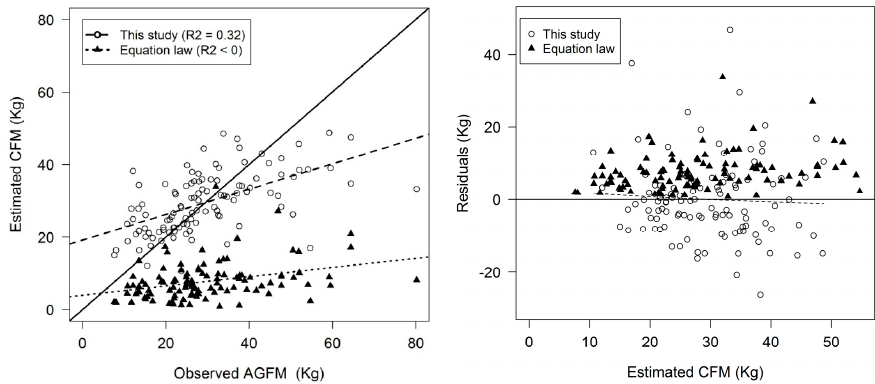
Figure 7. ( Left ) Comparison between allometric equation of this study and law-based equation for estimating rosewood crown fresh mass (CFM) and; ( Right ) Residuals distribution of the two allometric equations for CFM estimation.